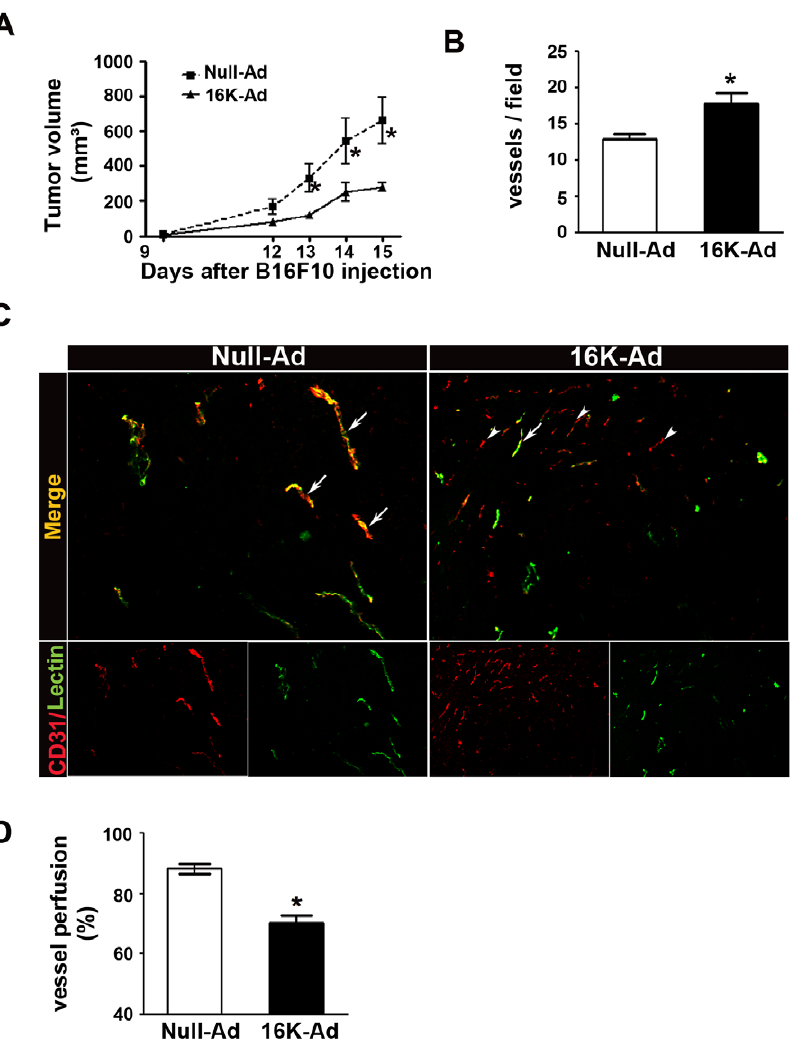
Figure 1. Inhibition of tumor growth by 16K hPRL is associated with an increased vessel number but with decreased vessel perfusion. (A) The data represent mean tumor volumes 6 SEM in 16K-Ad-treated (n=8) or Null-Ad-treated (n=10) mice. (B) The number of tumor vessels per field 6 SEM was determined on CD31-positive vessels in x100 power fields of each section. Bar , 100 m m. (C) Representative photographs of tumor sections from 16K-Ad- and Null-Ad-inoculated mice, double-stained for the endothelial cell marker CD31 (red) and the perfusion marker lectin (green). White arrows, vessels stained positive for CD31 and lectin. Heads of white arrows, vessels only positive for CD31. (D) The perfusion index was calculated as the percentage of lectin-positive vessels (perfused vessels) per CD31-positive vessels in the B16F10 tumors 6 SEM. For (B) and (D) the data represent, for each set of conditions, the mean ratio 6 SEM calculated for all the fields of all tumor sections (one section per tumor). *, P ,